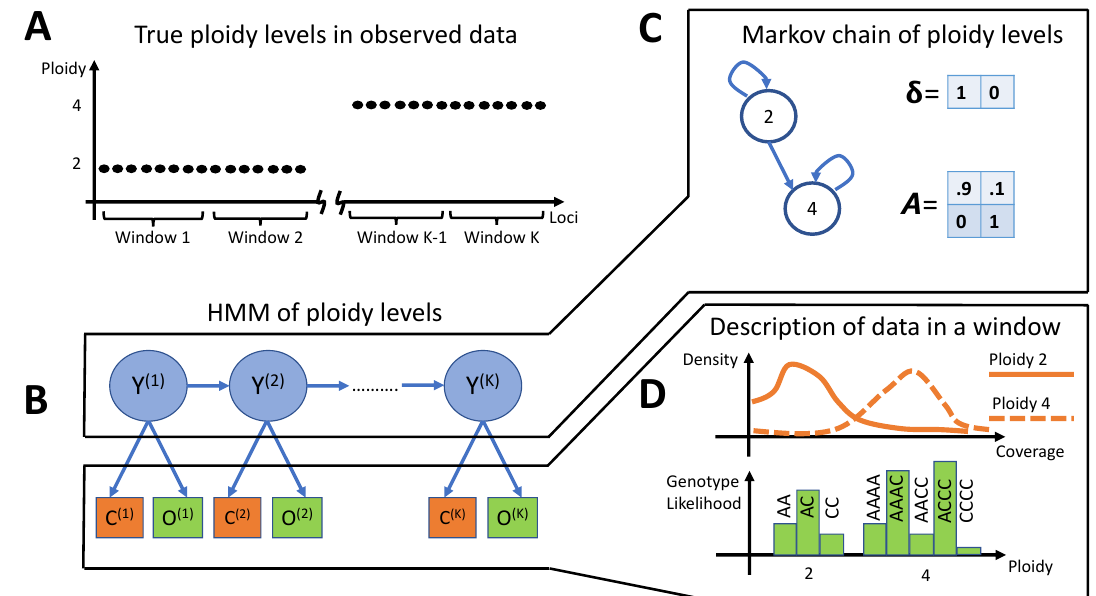
Figure 1. HMM for two ploidy levels. (A) Consider a NGS dataset consisting of a sequence of two ploidy levels. (B) The HMM describing the data has a sequence of hidden states Y